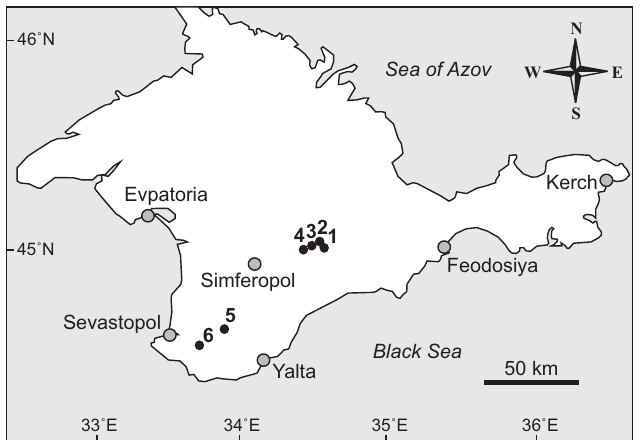
Fig. 2. Geographical position of the studied oysters locations. 1, Cherno- kamenka village; 2, Sarysu river; 3, Balki village; 4, Mezhgorye village; 5, Solnechnoselye village; 6, Kuchki village.